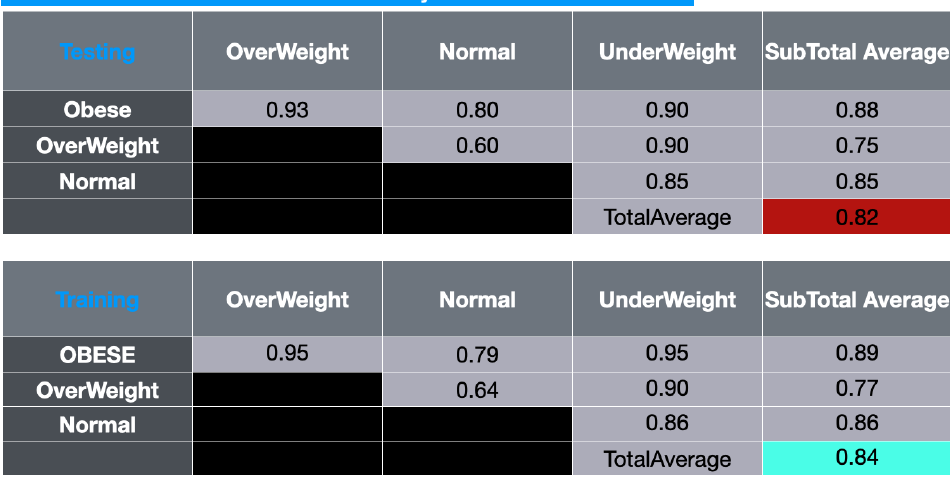
Figure 12. One-vs.-one